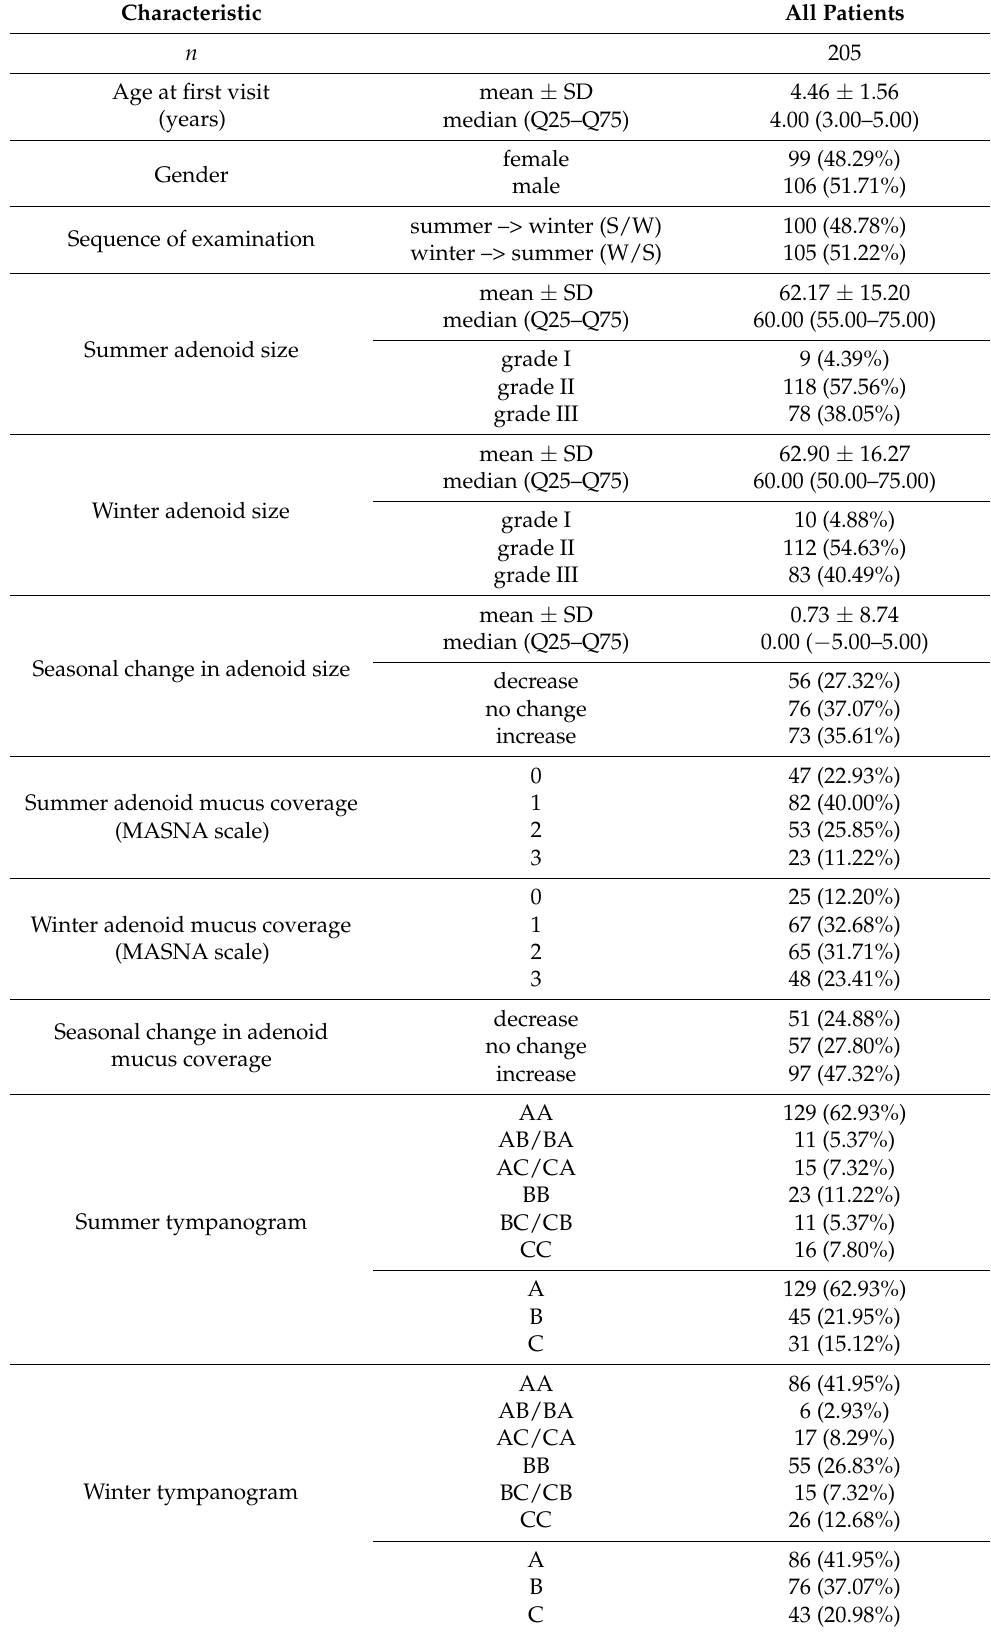
Table 1. Patient